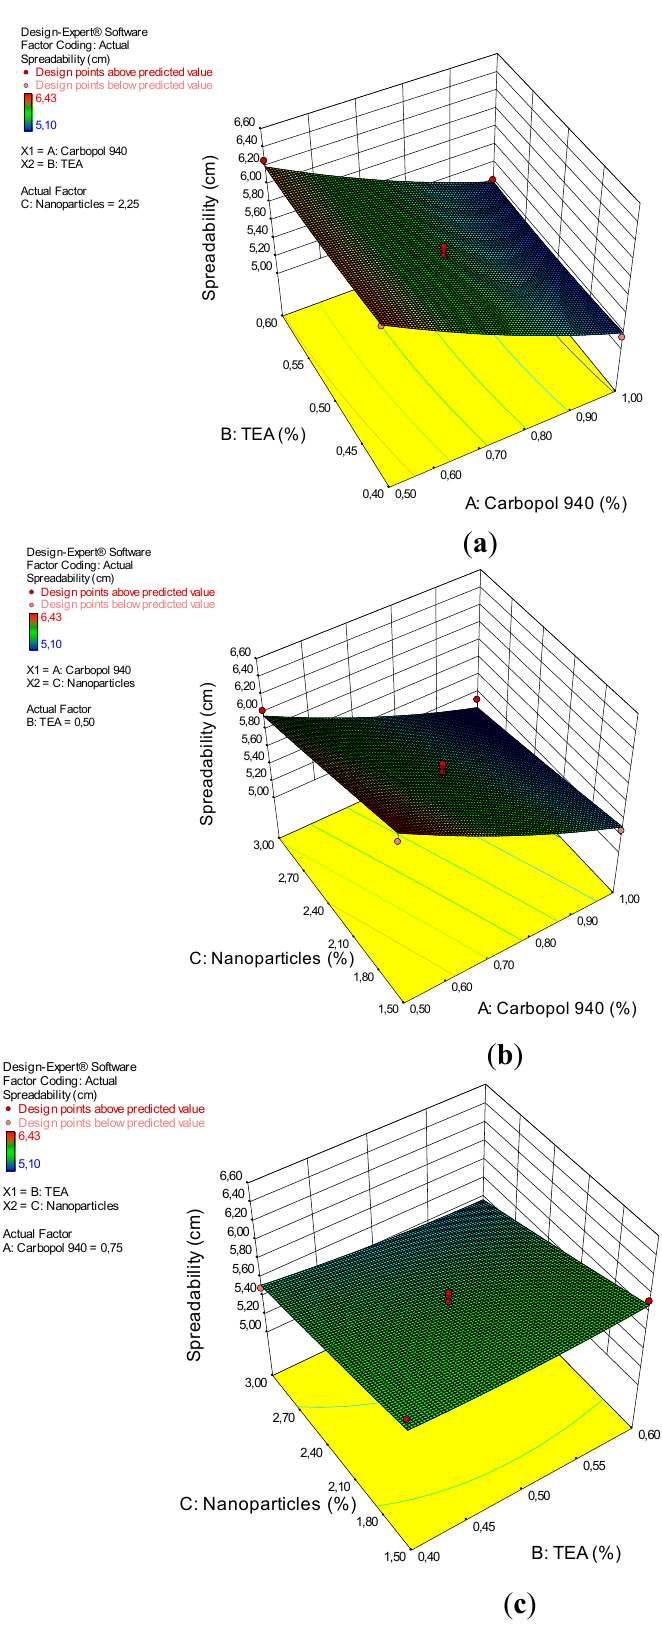
Figure 4. 3D plot of the relationship between ( a ) carbopol 940 and TEA and the spreadability, ( b ) carbopol 940 and nanoparticles and the spreadability, and ( c ) TEA and nanoparticles and the spreadability.